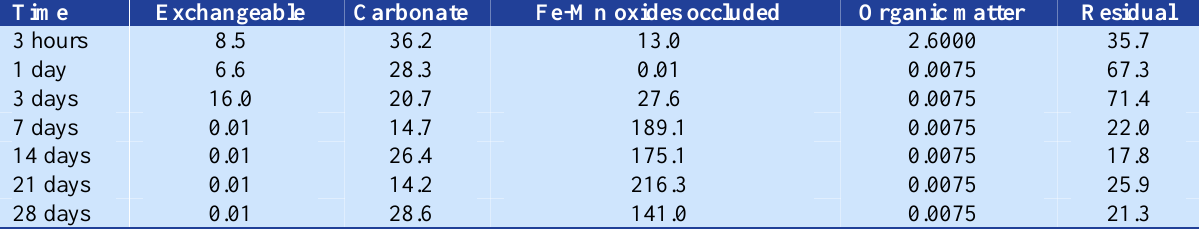
Table 4. Concentration (mg/kg) of the Cu in each fraction in the control soil